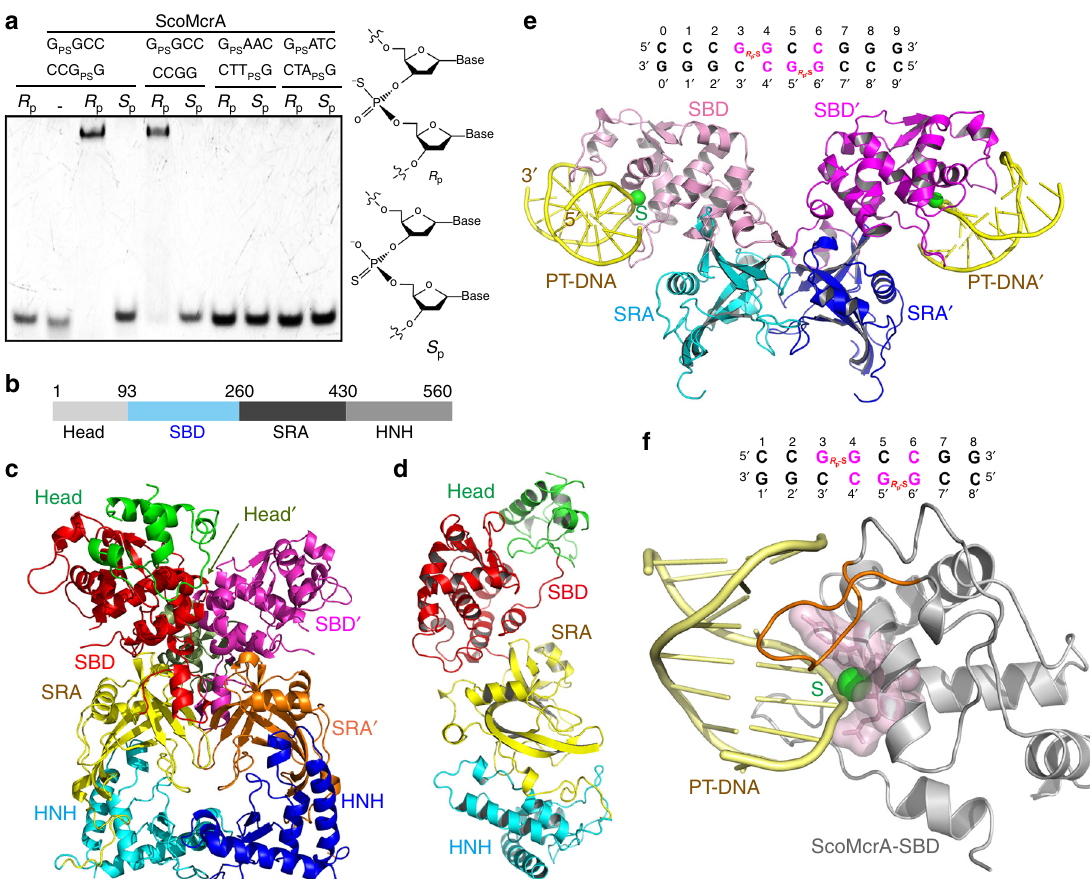
Fig. 1 ScoMcrA employs its SBD domain to recognize PT-DNA. a Streptomyces coelicolor ScoMcrA speci fi cally associated with PT-DNA and hemi ‒ PT-DNA containing the G PS GCC core sequence, with the sulfur atom in the R p , but not in the S p , stereo-speci fi c con fi guration. Lane 1 serves as a control with no protein added. b Domain organization of ScoMcrA. c Structure of the full-length ScoMcrA dimer. The four domains of ScoMcrA, head, SBD, SRA, and HNH domains, are labeled. d Structure of a ScoMcrA protomer. e Structure of ScoMcrA ‒ SBD-SRA in complex with a 10 base pair PT-DNA. The DNA sequence is shown at the top, with the bases recognized by ScoMcrA highlighted in magenta. f Structure of ScoMcrA ‒ SBD in complex with an eight base pair PT-DNA. Sulfur-recognizing residues are shown in stick as well in surface representations. The “ S 187 RGRR 191 loop ” recognizing the bases of PT-DNA is colored